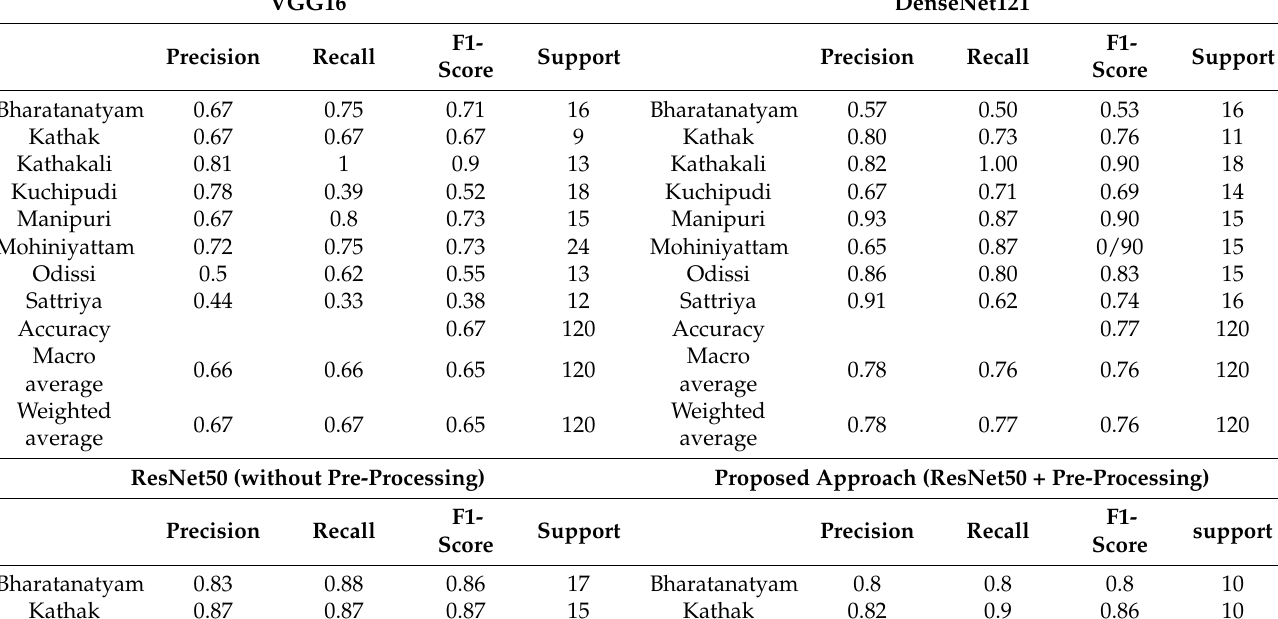
Table 2. Classification report for baseline